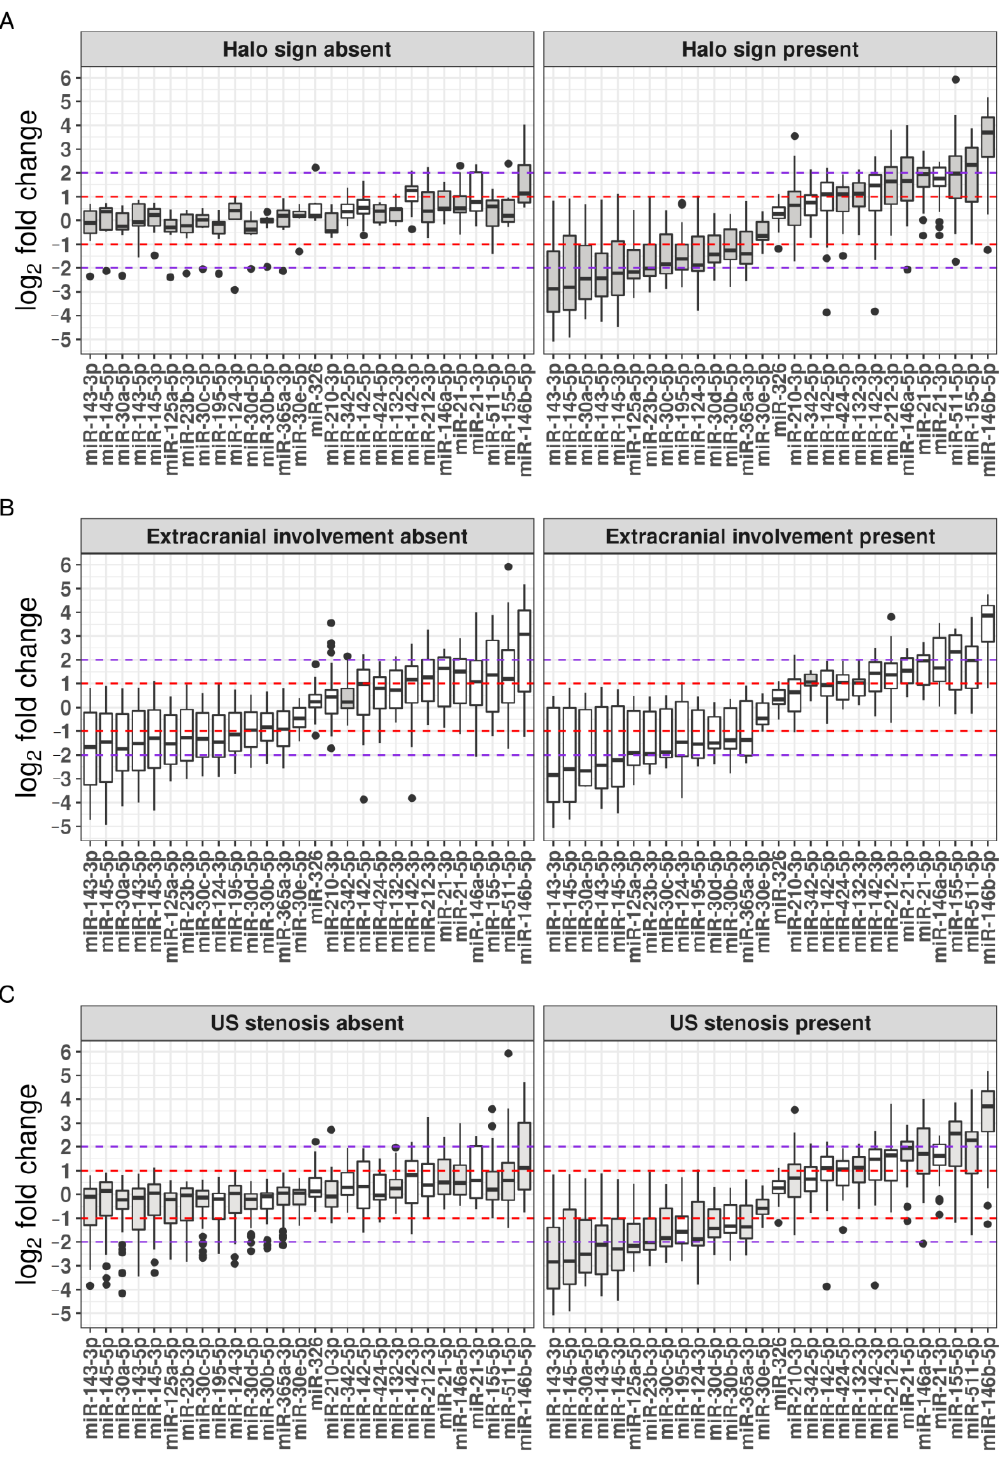
Figure 4. Expression profiles of 28 miRNAs in TABs from 46 GCA patients in relation to US exam- ination parameters. Boxplots depict log 2 fold-change values of each miRNA. Differential miRNA expression in patients with and without the TA halo sign present ( A ), in patients with and without extracranial involvement ( B ), and in patients with and without luminal stenosis ( C ). The red and vio- let dotted lines delineate two- and four-fold-change threshold of each miRNA, respectively. miRNAs exhibiting significant differential expression between patient groups are highlighted in